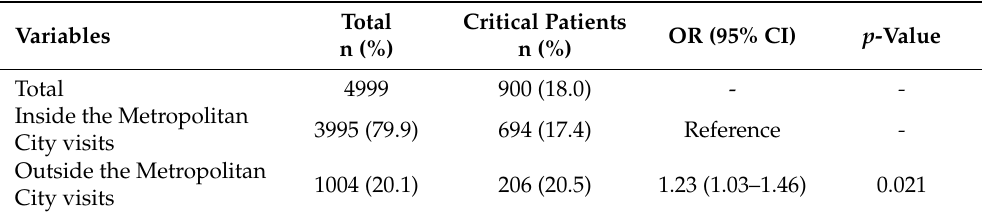
Table 3. Comparison of the number of visits by patients with COVID-19-related symptoms from inside and outside the Daegu Metropolitan City.